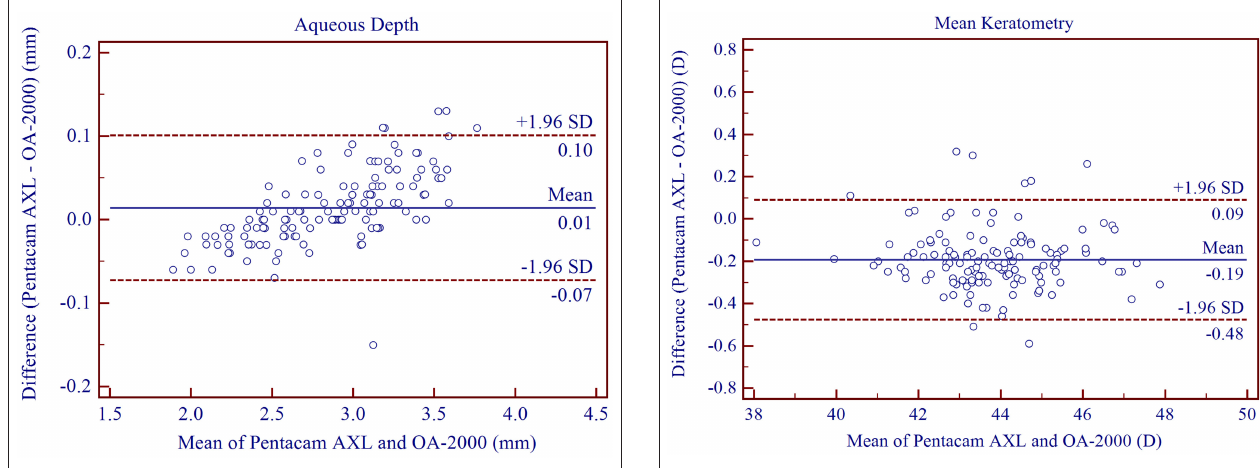
FIGURE 3 | Bland-Altman plots showing the agreement between the new Scheimpflug imager in combination with partial coherence interferometry biometer and the swept-source optical coherence tomography-based biometer for measuring aqueous depth. Solid lines represent the bias between the two devices and dotted lines represent the 95% confidence interval for the difference.